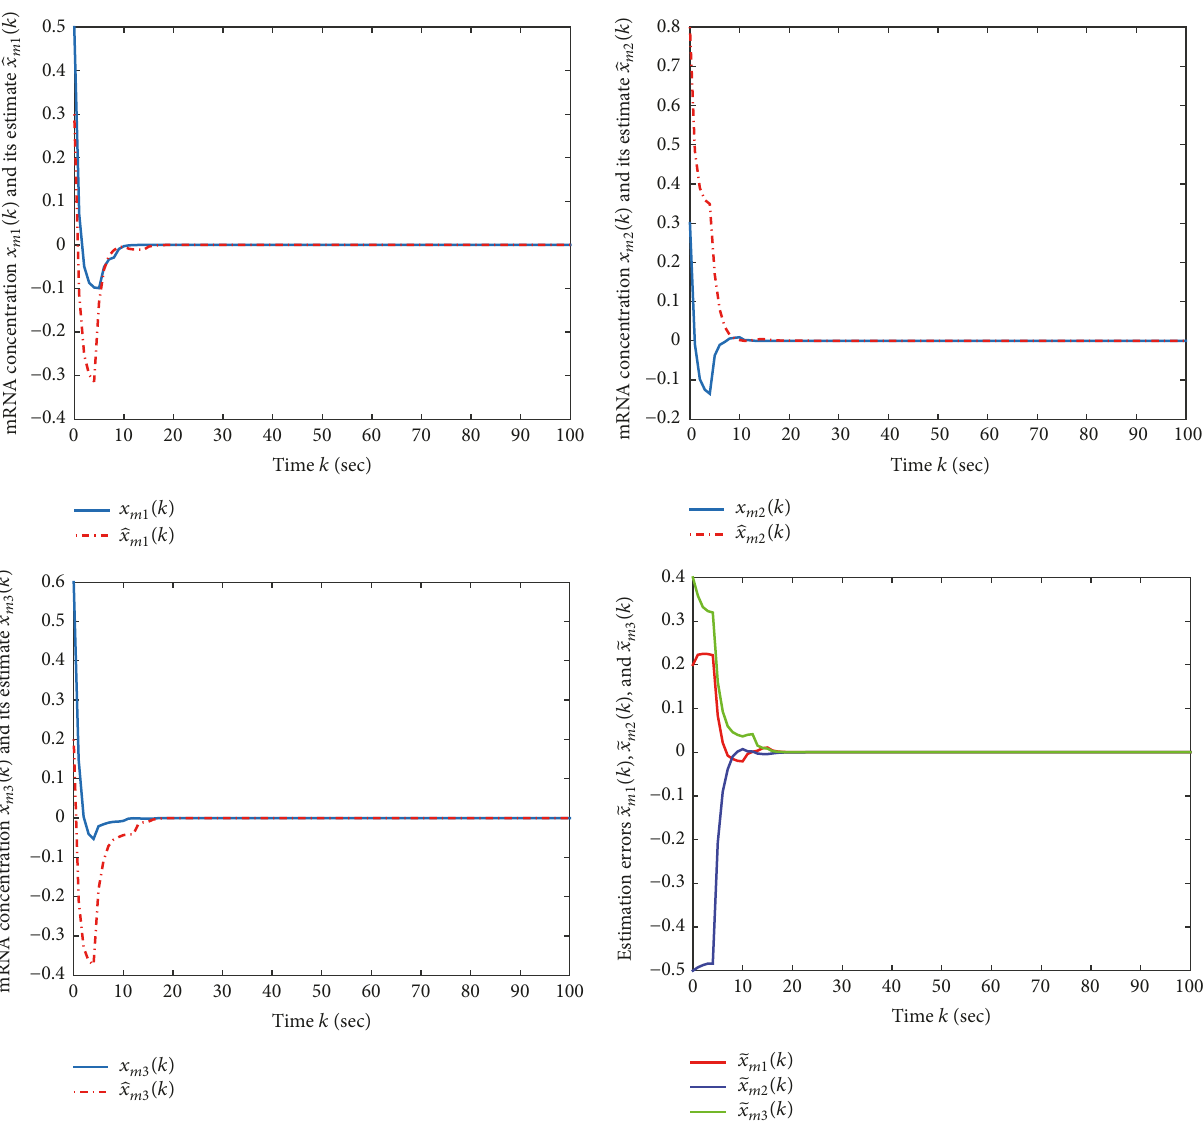
Figure 3: mRNA concentrations, its estimates, and the estimation error of Example